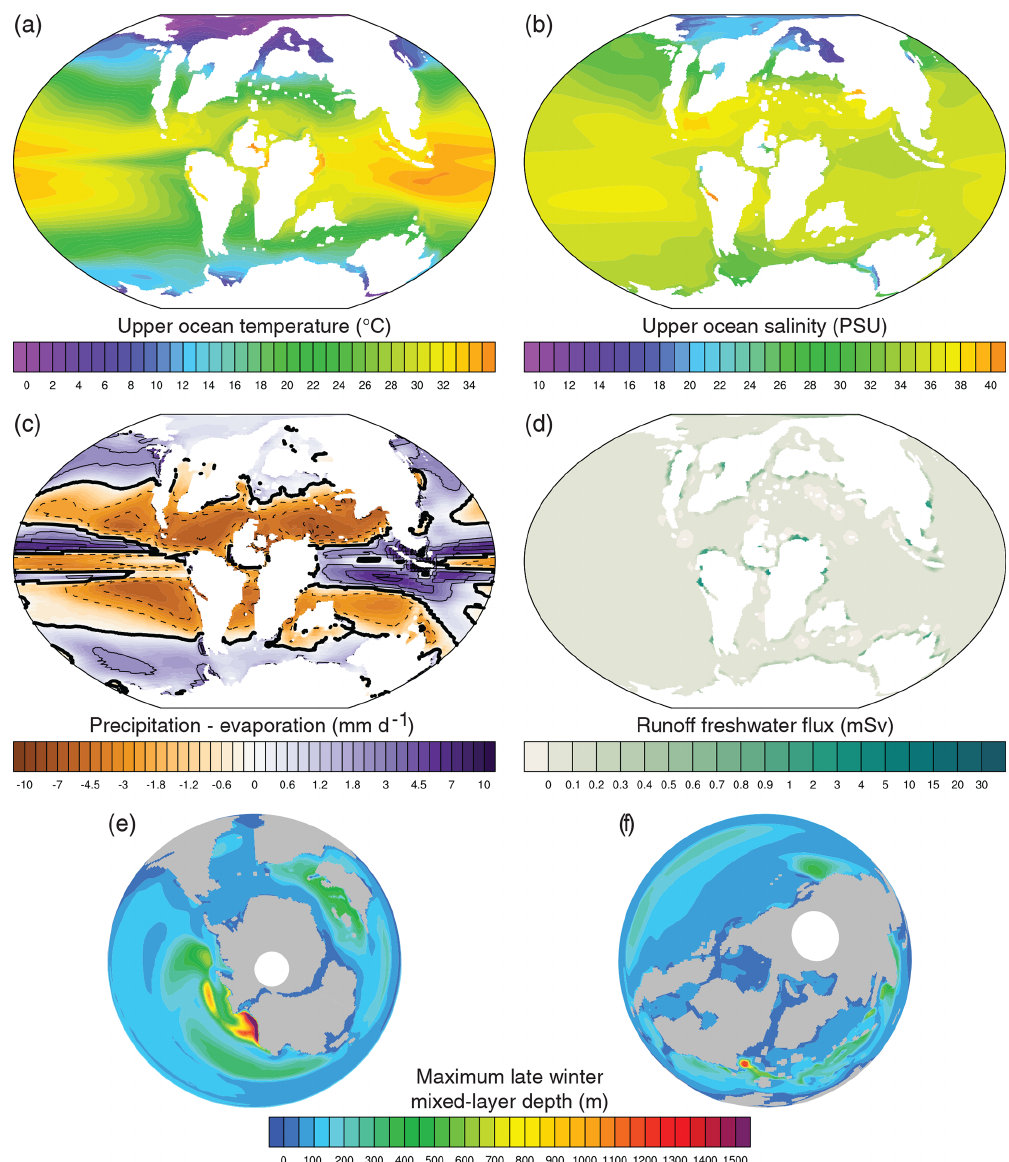
Figure 3. Climate diagnostics for the Cenomanian simulation. (a) Surface ocean (upper 100m) temperature ( ◦ C). (b) Surface ocean (upper 100m) salinity (PSU). (c) Precipitation minus evaporation (mmd − 1 ). (d) Runoff freshwater flux (mSv). (e, f) Late winter maximum mixed layer depth